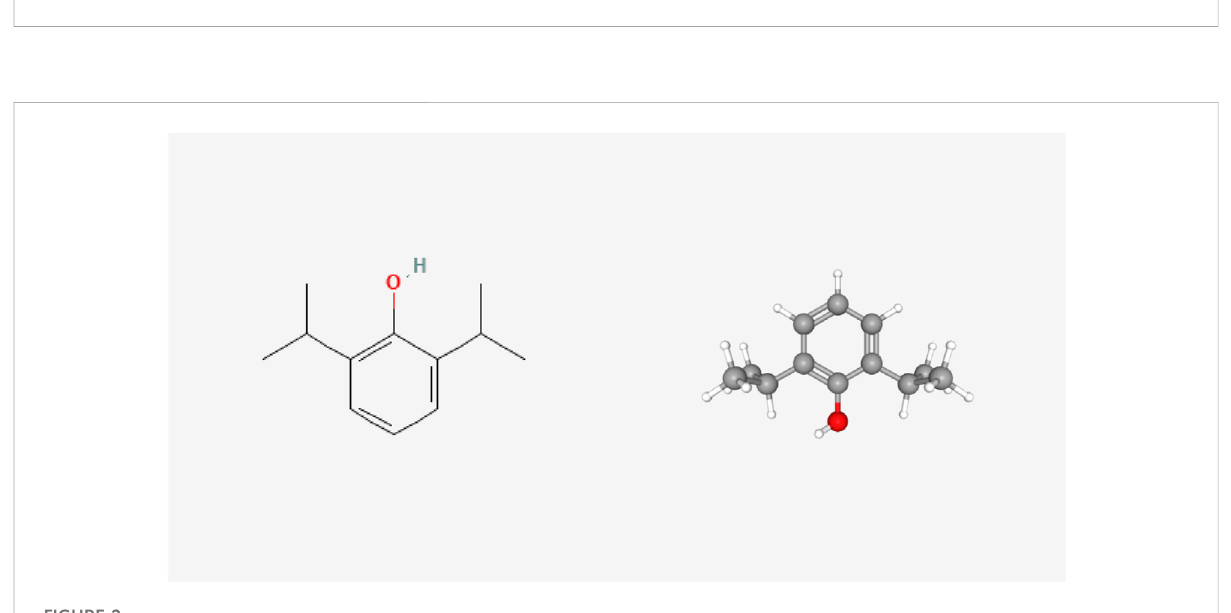
FIGURE 2 2D and 3D chemical structure of